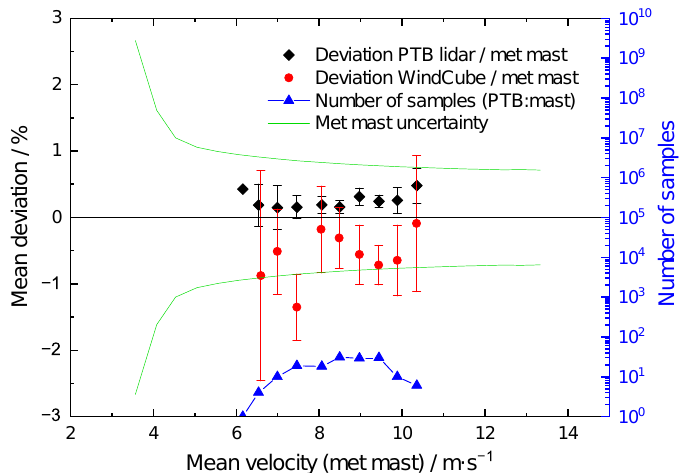
Figure 8. Results of the 2016 comparative measurement between the PTB bistatic lidar and the top anemometer and between the monostatic lidar (WindCube) and the top anemometer in undisturbed flow at a measurement height of 135 m, evaluated according to IEC 61400-12-1 using 10 min intervals. For bins in which at least 10 values were obtained, the PTB bistatic lidar’s deviation is less than 0.5%, which is well within the cup anemometer’s measurement uncertainty (roughly between ± 1% at 4 m · s − 1 and ± 0.7% at 13 m · s − 1 ). Under the same conditions, the monostatic lidar shows deviations up to −